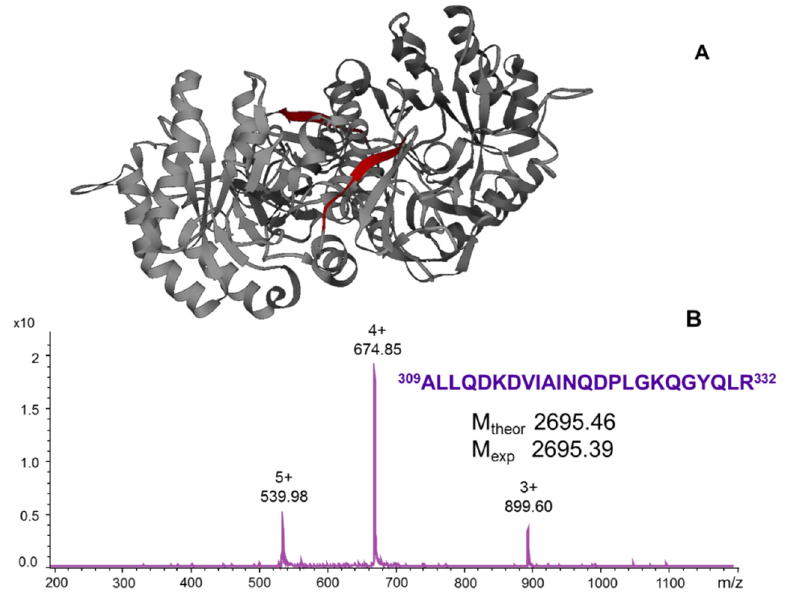
Figure 6. Tertiary structure docking of the α Gal (309–322) epitope in the enzyme structure ( A ) and ESI-mass spectrum of the epitope from the affinity elution fraction after α − Gal tryptic digestion ( B ). The m/z values of peaks correspond to the charge states of multiply protonated peptide ions [62]. Table 2. Binding affinities of full length α -Gal protein and α -Gal epitope peptides determined by SPR.